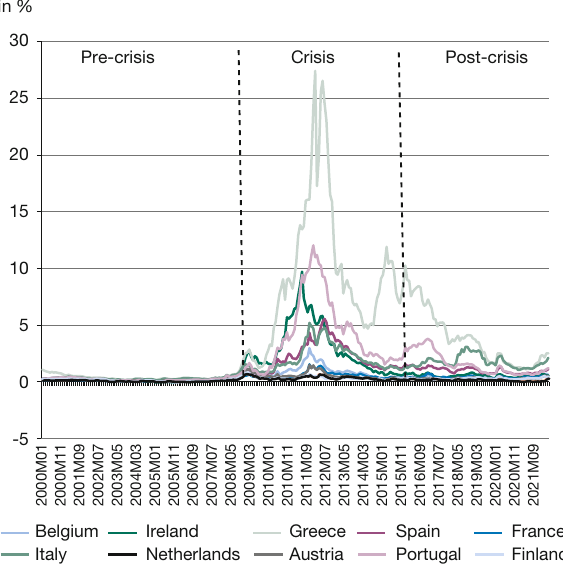
Ten-year government bond spreads, selected eurozone countries,